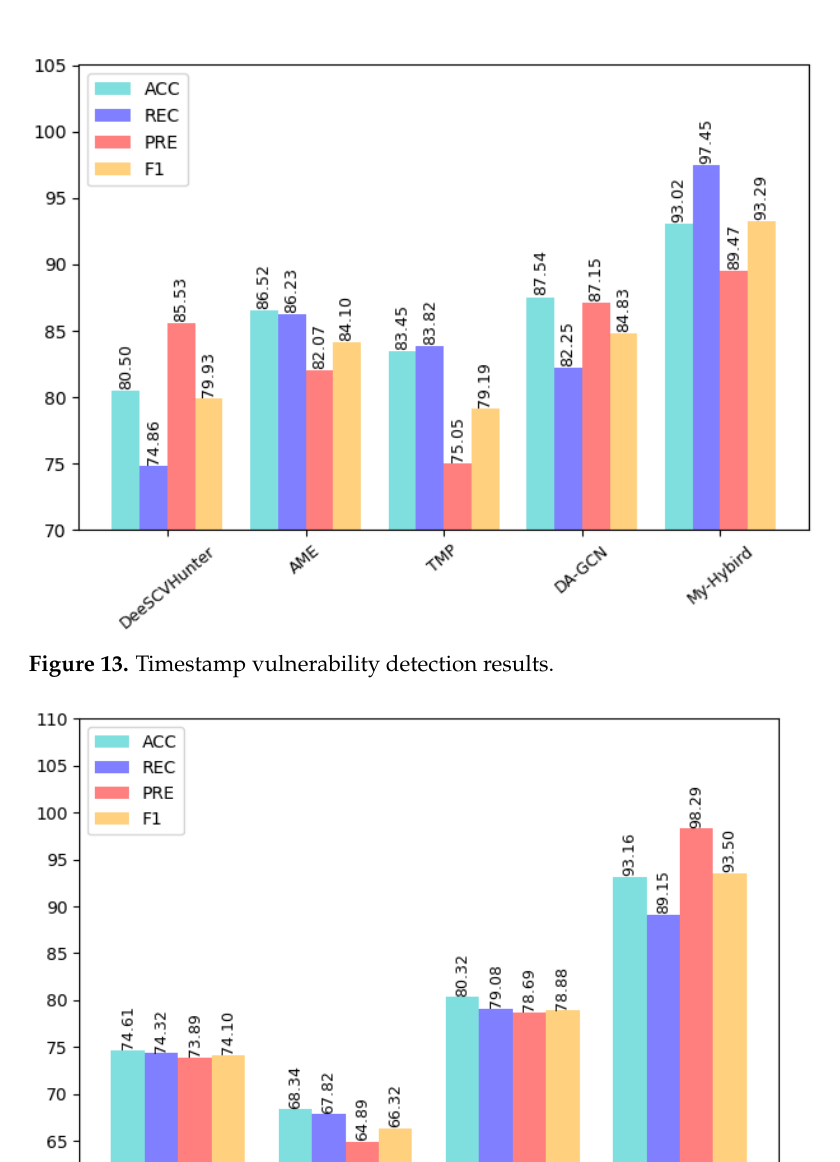
Figure 12. Reentry vulnerability detection results.